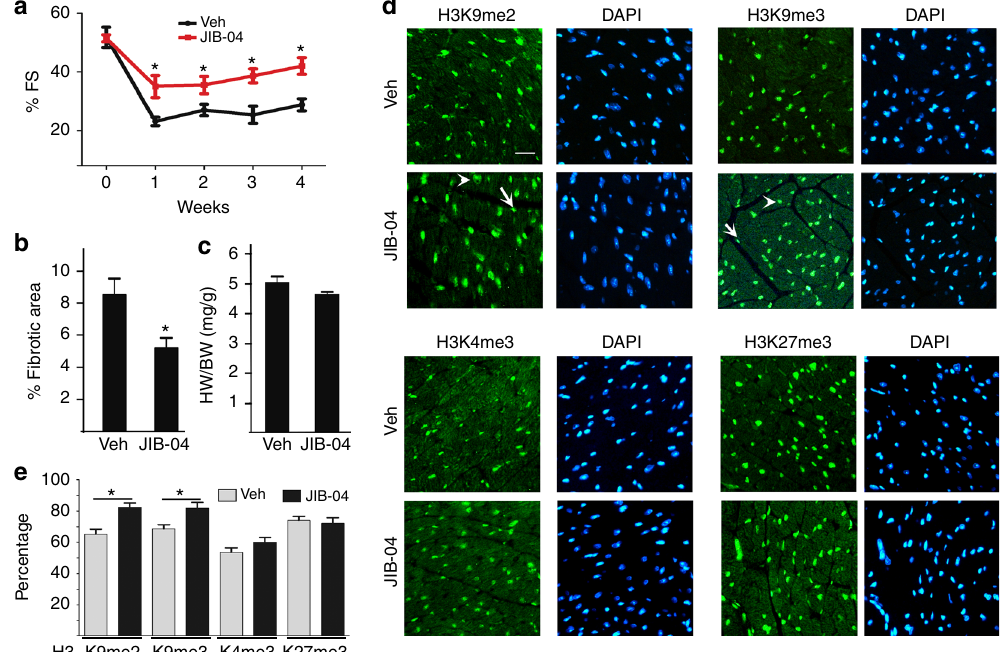
Fig. 7 JIB-04 protects mice against I/R injury. WT mice were subjected to I/R surgery and given vehicle (Veh) or JIB-04 as shown in Fig. 6a. Echocardiographs were performed weekly for 4 weeks to measure the fractional shortening ( a ). b Percent fi brotic area and c HW/BW ratio of mice treated with Veh or JIB-04 at 4 weeks post-I/R surgery. d Immuno fl uorescences of H3K9me2, H3K9me3, H3K4me3, and H3K27me3 of hearts treated with Veh or JIB-04 at week 4 post-I/R surgery. H3K9me2/3 in both cardiomyocyte (arrow head) and non-cardiomyocytes (arrow) were affected by JIB-04 treatment. Scale bar, 20 μ m. e Quanti fi cation of percent of cells in d stained with methylated histones as indicated. Staining of methylated histones was normalized against Dapi stained cells. * p < 0.05, n = 5 ± SEM